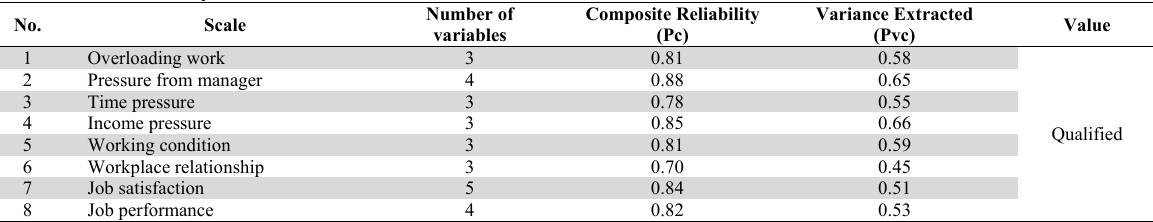
Testing the relationship among factors Overloading